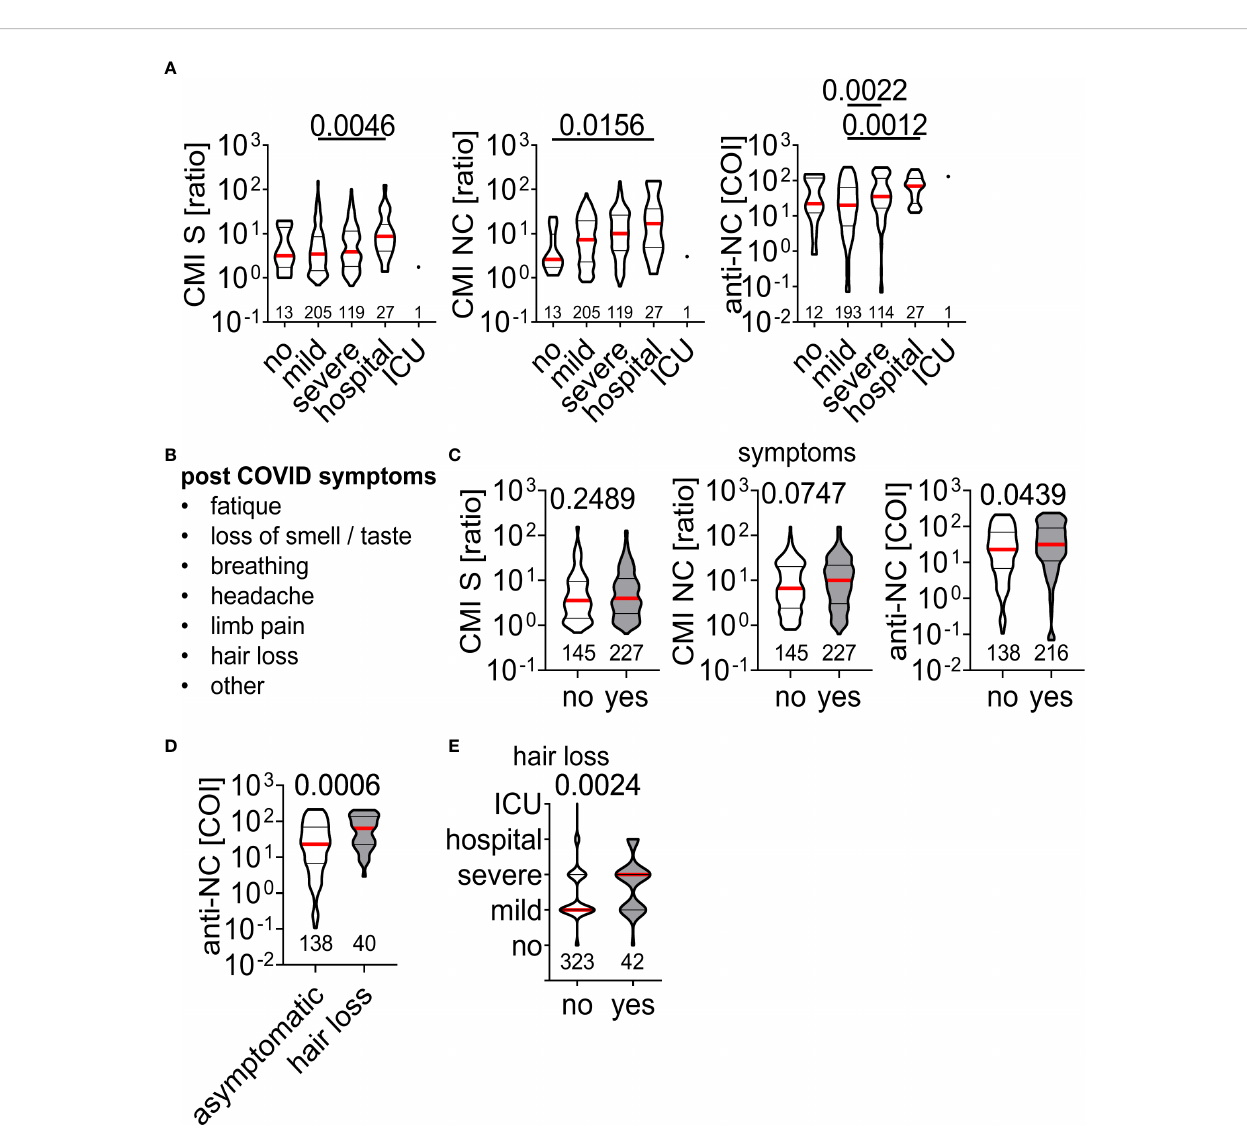
FIGURE 5 Association of acute and chronic clinical course of SARS-CoV-2 infection on measurements of adaptive immunity (A) Clinical course during acute SARS- CoV-2 infection with corresponding IFN- ɣ responses to peptide stimulation or antibody titers. Difference between groups was assessed by Kruskal-Wallis with Dunn ’ s multiple comparisons test and p-values below 0.05 are provided above each diagram. The number of individuals per group included in the analysis are provided within the diagrams. (B) List of post COVID symptoms retrieved in the questionnaire at time of sample acquisition and (C) test results in dependence of absence (no) or presence (yes) of symptoms. (D) Anti-NC titers of asymptomatic individuals and those who developed hair loss post SARS-CoV-2 infection. (E) Clinical course during acute SARS-CoV-2 infection of individuals with absence (no) or presence (yes) of hair loss. Differences in (C-E) were assessed by Mann Whitney test and p-value is